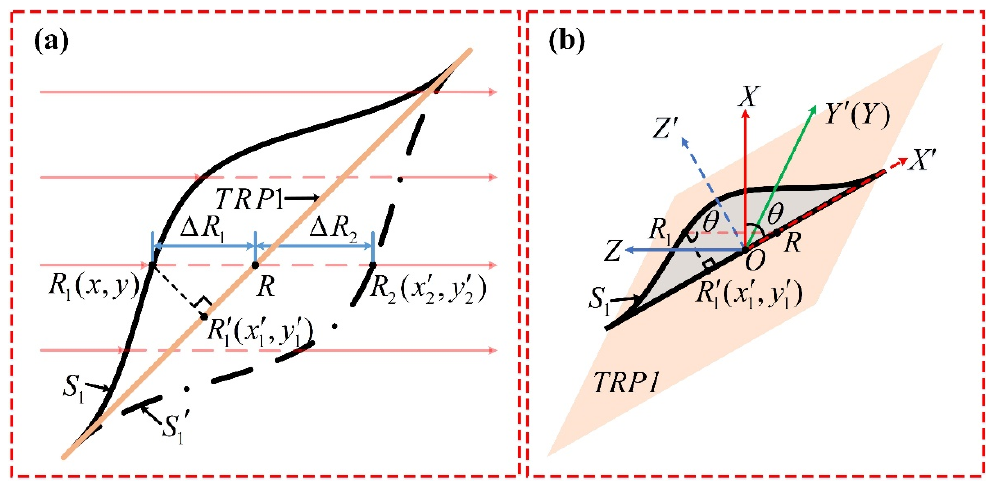
Figure 3. ( a ) The XZ -section of RM1; ( b ) the coordinate of the TRP1 and cavity.